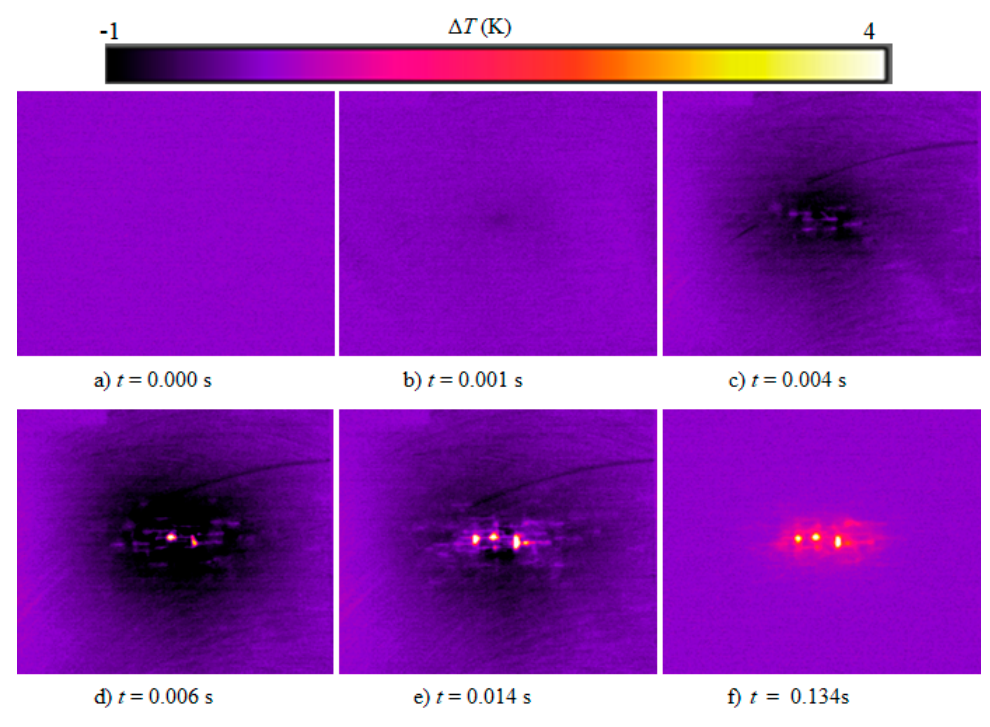
Figure 2. Some ∆ T images of a GFRP specimen impacted at E = 8.3